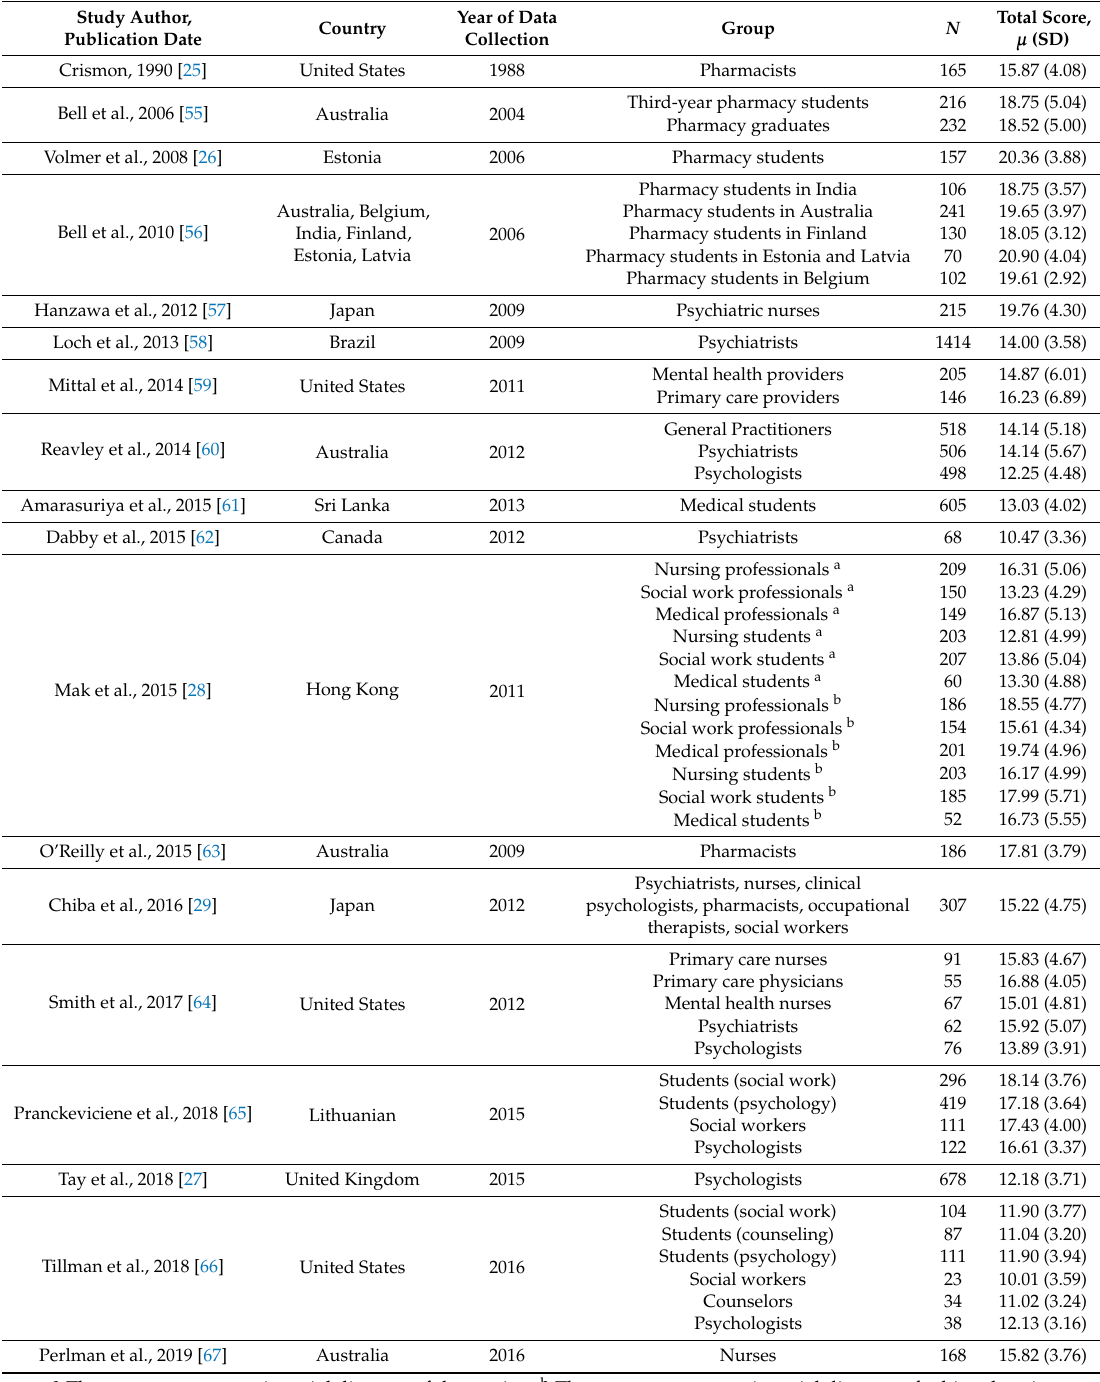
Table 1. Summary of characteristics of the 18 Social Distance Scale (SDS)